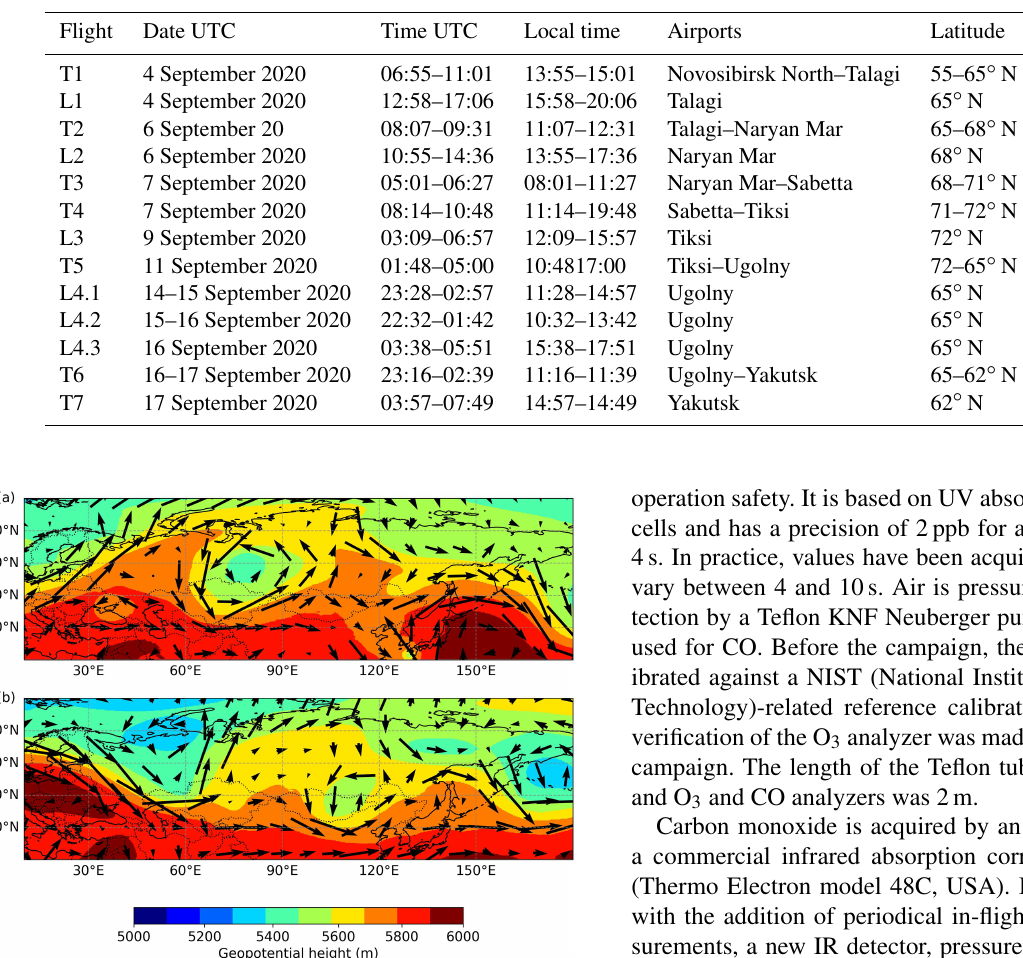
Figure 3. (a) Geopotential height and wind (speed and direction) at 500hPa from ECMWF reanalyses for 6 September at